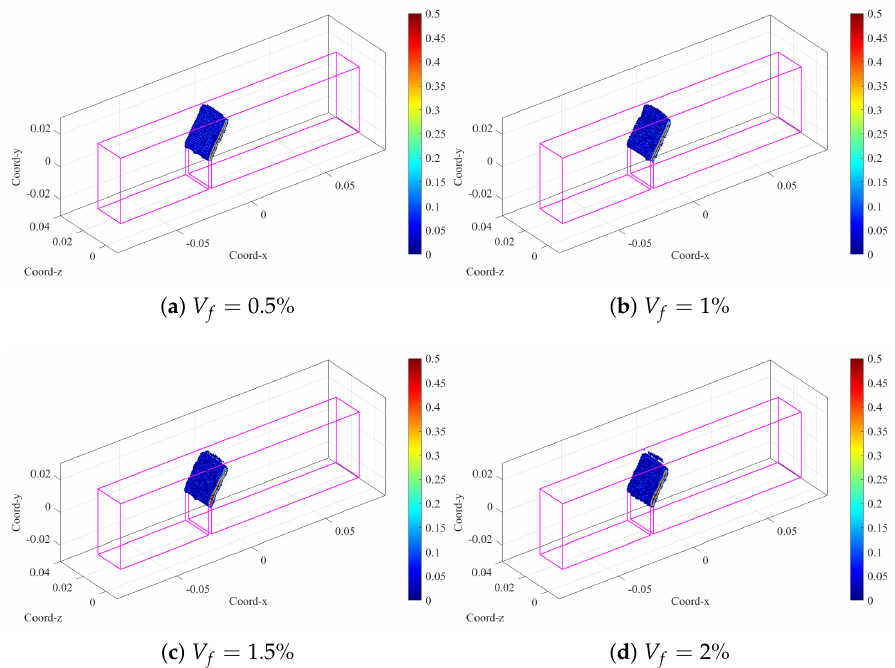
Figure A2. Damage levels in the simulated UHPC-PVA beam specimens with C l = 20 mm.